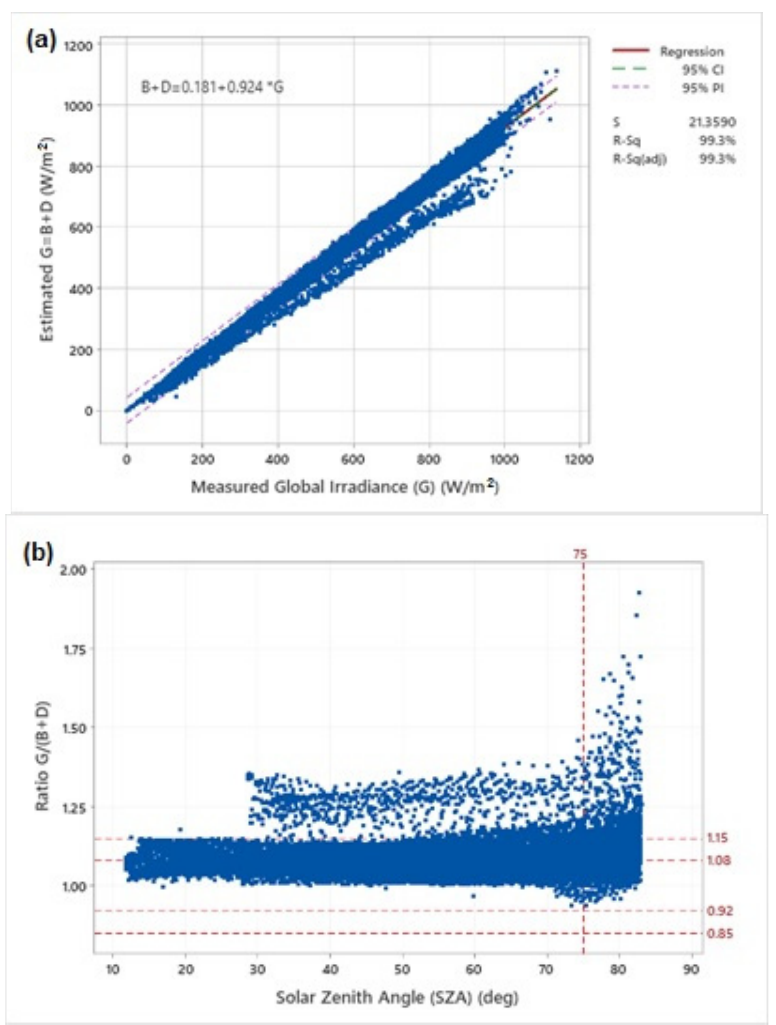
Figure 10. ( a ) linear regression of the estimated sum of the measured irradiances ( B + D ) and the relevant global irradiances ( G ); and ( b ) Ratio of G /( B + D ) as a function of solar zenith angle (SZA) with the reference lines within the ratio should be detected.